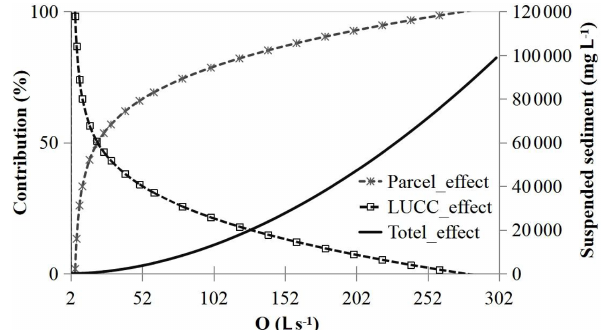
Figure 8. The contribution of the Parcel_effect and LUCC_effect to the Total_effect across various flow rates. The Total_effect (Eq. 4) is displayed in terms of suspended sediment concentration. The Par- cel_effect and LUCC_effect were estimated using Eqs. (5) and (6), respectively; their contribution to the Total_effect was estimated us- ing Eqs. (7) and (8),